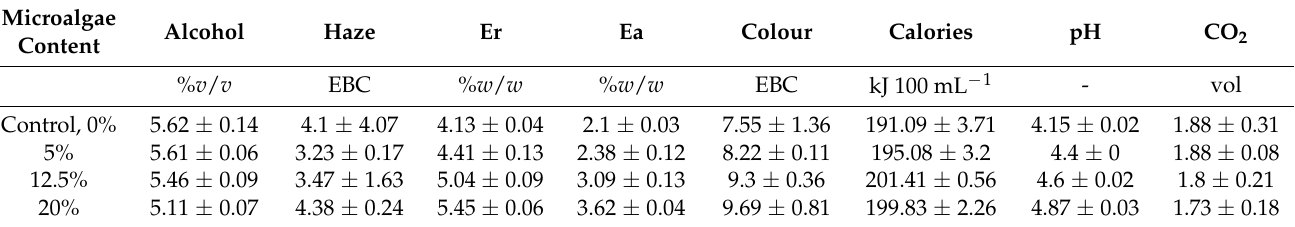
Table 3. Anton Paar Alcolyzer results from brewing trials, presented as mean ± SD, using three different algae:malt mixtures vs.